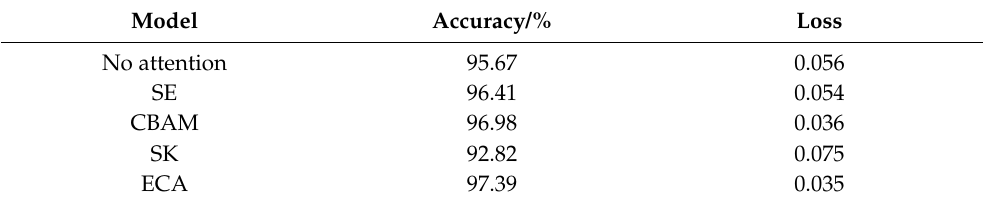
Table 5. Comparison of the results obtained with different attention mechanisms.